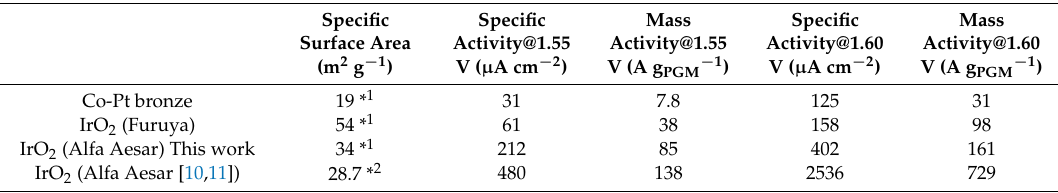
Table 2. OER activity comparison.